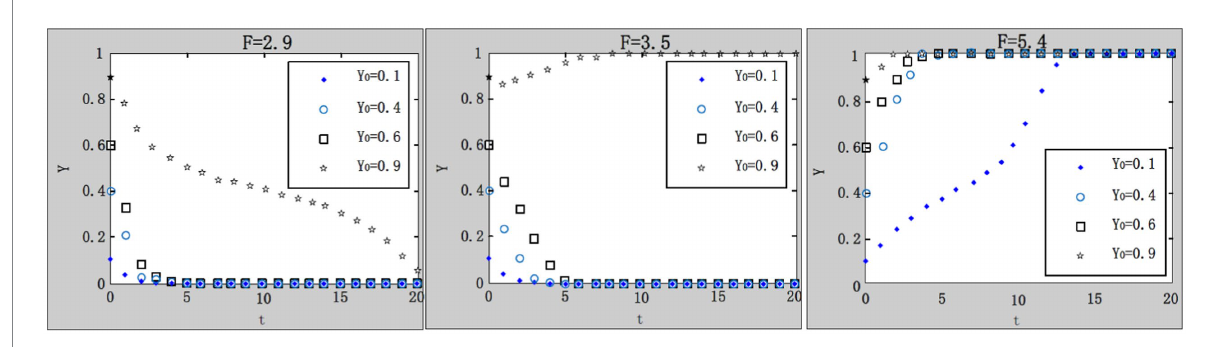
FIGURE 6 Influence of local government’s ex post penalties on system